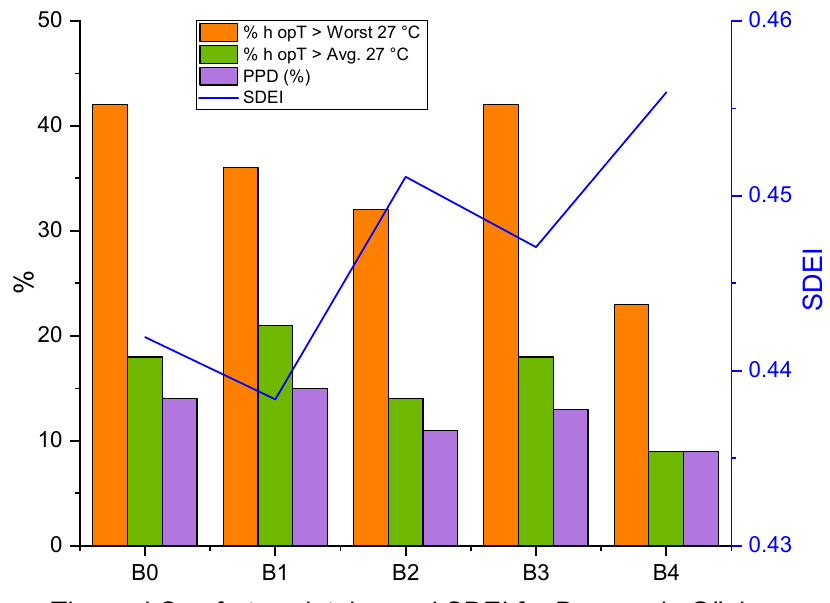
Figure 13. Thermal comfort main indicators as well as SDEIs for B0–B4 in Gävle.